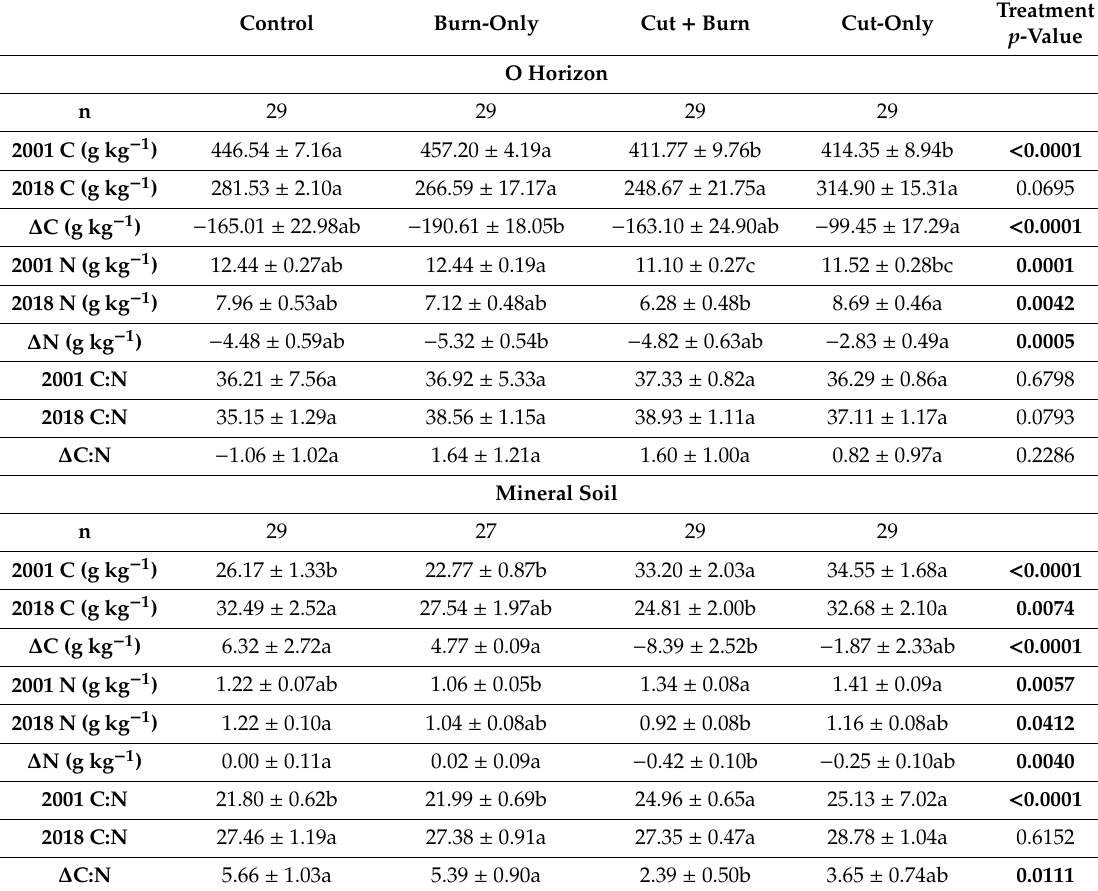
Table 1. 2001 and 2018 O horizon and mineral soil carbon, nitrogen, and C:N values ( ± mean standard error) and their di ff erences ( ∆ ) obtained on the Green River Game Lands near Asheville, NC, USA. Significant di ff erence determinations for mean and mean ∆ values are bolded ( α = 0.05) and Tukey’s HSD di ff erences between treatments (across rows) are noted by letter distinctions.